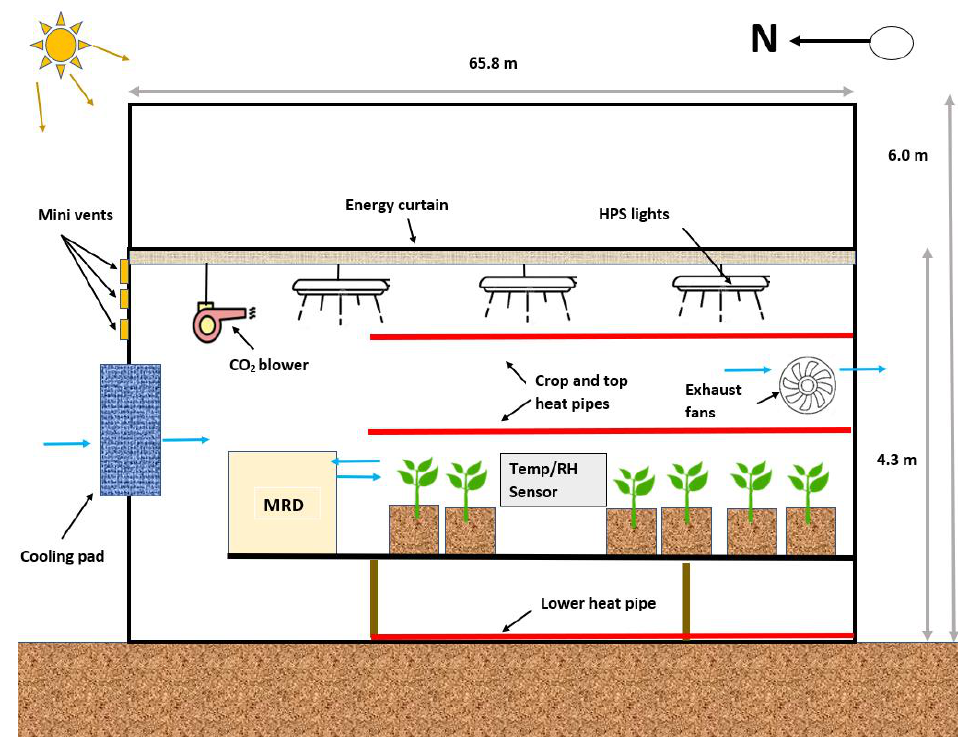
Figure 1. Cross-section schematic of Section A (with MRD).